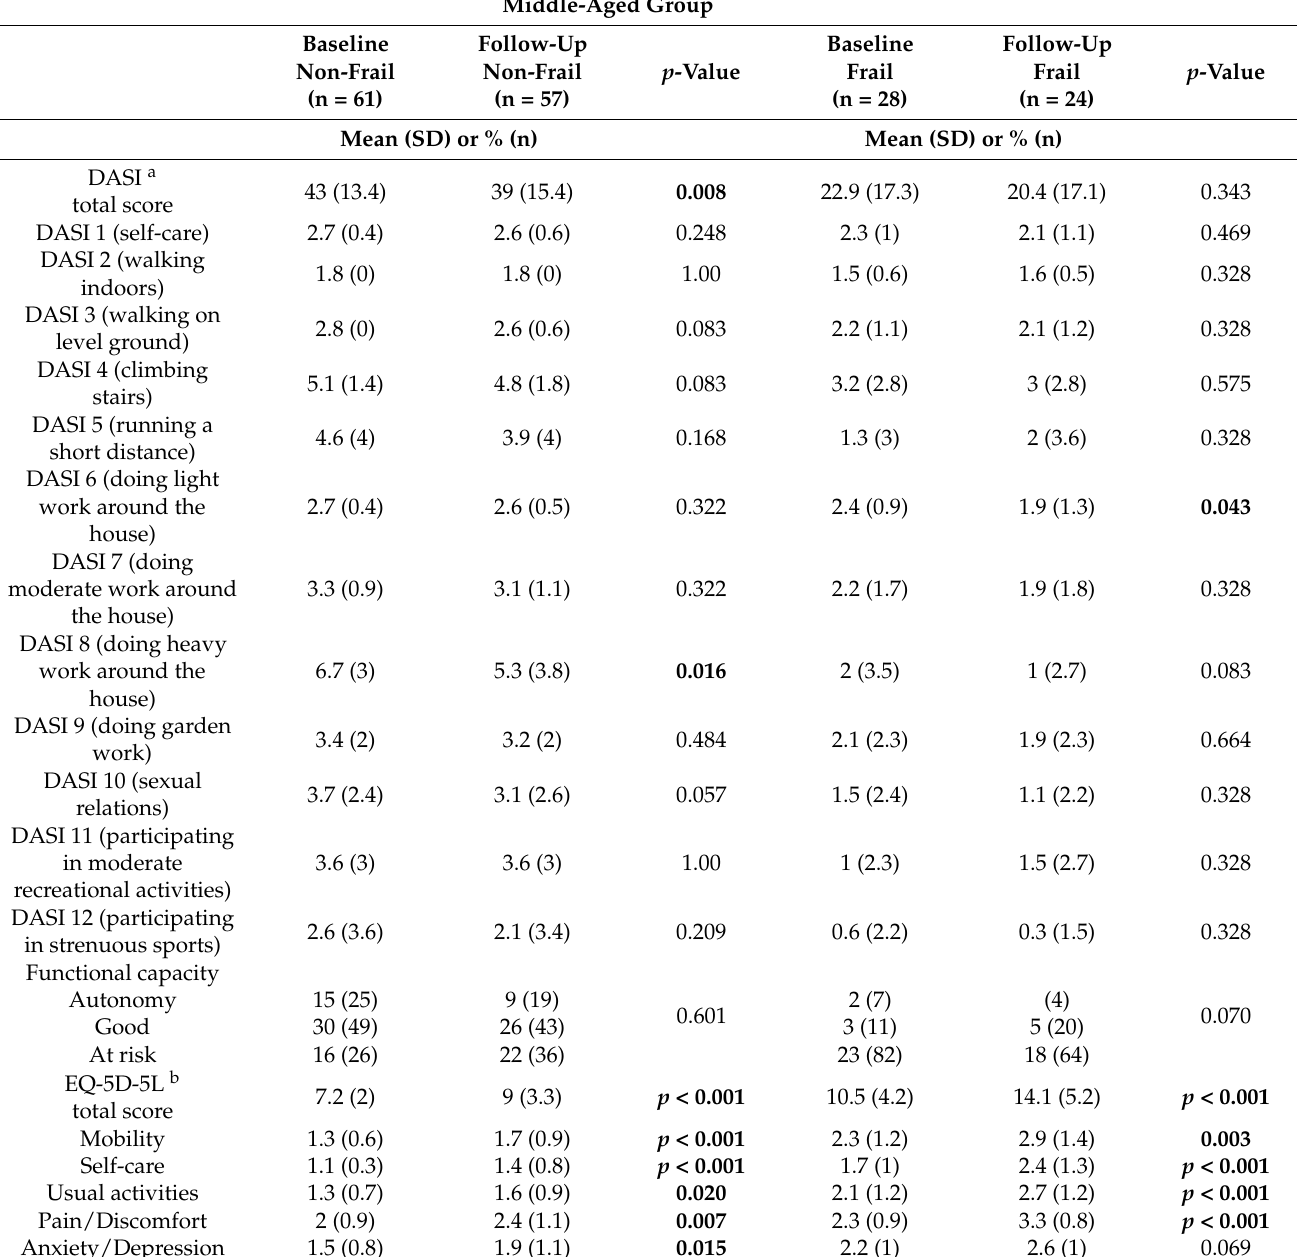
Table 4. Mean differences regarding functional status and QoL within middle-aged group at follow- up. Quantitative variables are expressed as mean (M) and standard deviation (SD), and qualitative variables as a